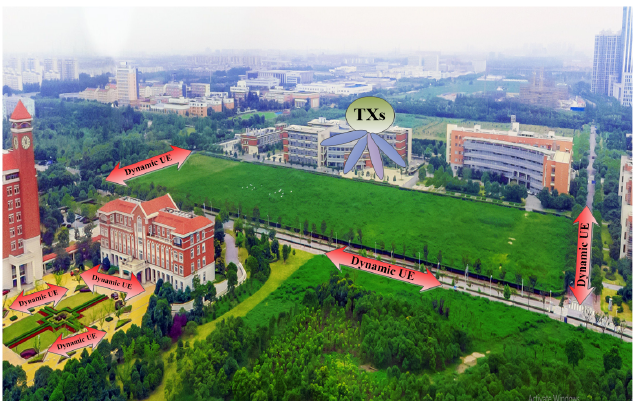
Figure 4. Overview of the measurement area at the campus of Shanghai Jiao Tong University, China. A spaced rectangular antenna array with 16 cross polarized patch antenna elements at the TX was placed on the rooftop of the Biomedical building during their respective measurement campaigns and a spaced uniform linear array as a user was moved around the international buildings acting as multiple-antenna